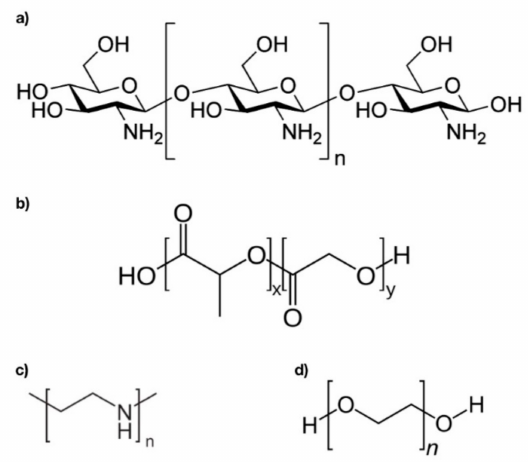
Chemical structures of polymer materials for DNA vaccine delivery. ( a ) Chitosan; ( b ) Poly(lactic- co -glycolic acid) (PLGA); ( c ) Polyethylenimine (PEI); ( d ) Poly(ethylene glycol)